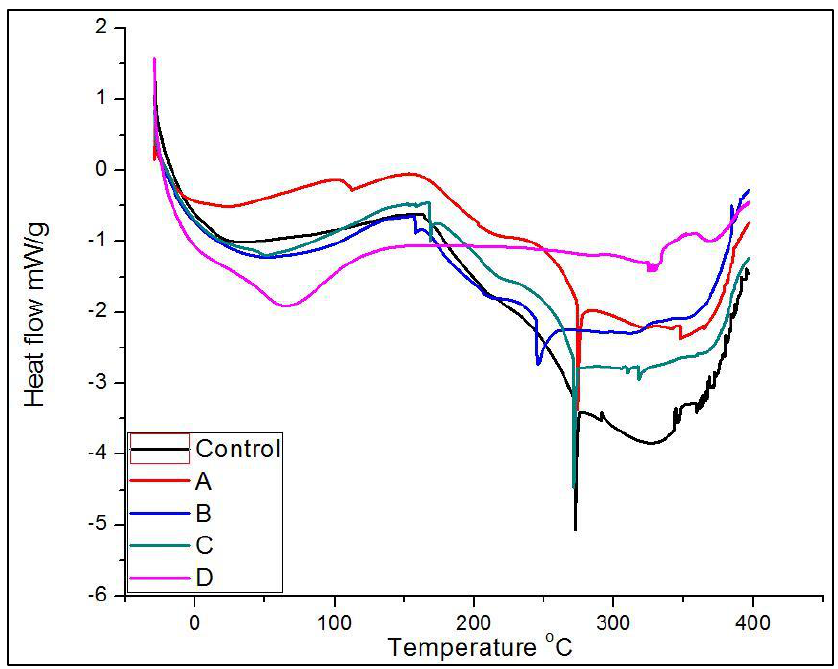
Figure 5. DSC curves of PUF control and CNF-PUF with 10–40% CNF replacement ratios.